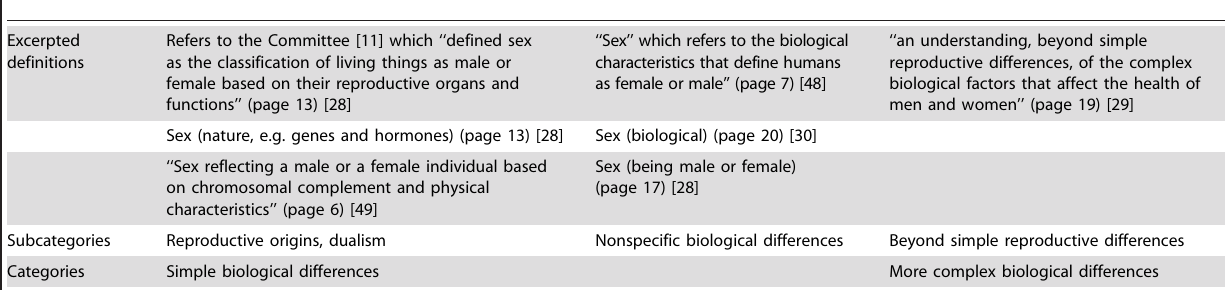
Table 3. Excerpted definitions, subcategories and categories in the qualitative coding of the concept ‘sex’*.